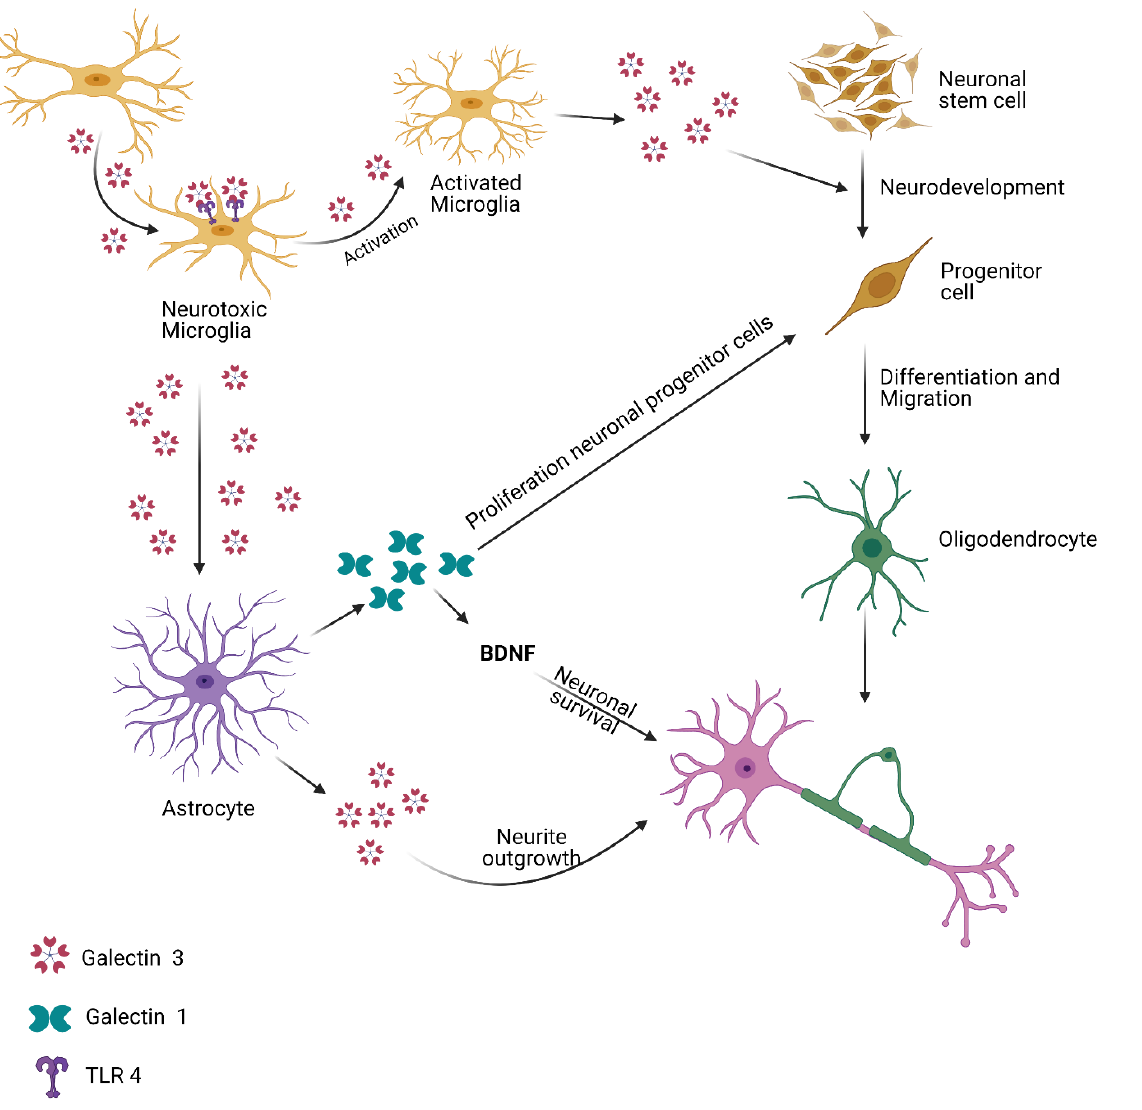
Figure 2. Role of galectins in microglia and astrocyte activation.